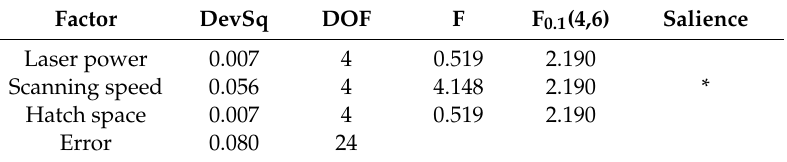
Table 7. Significant level of each factor under a layer thickness of 45 µ m.